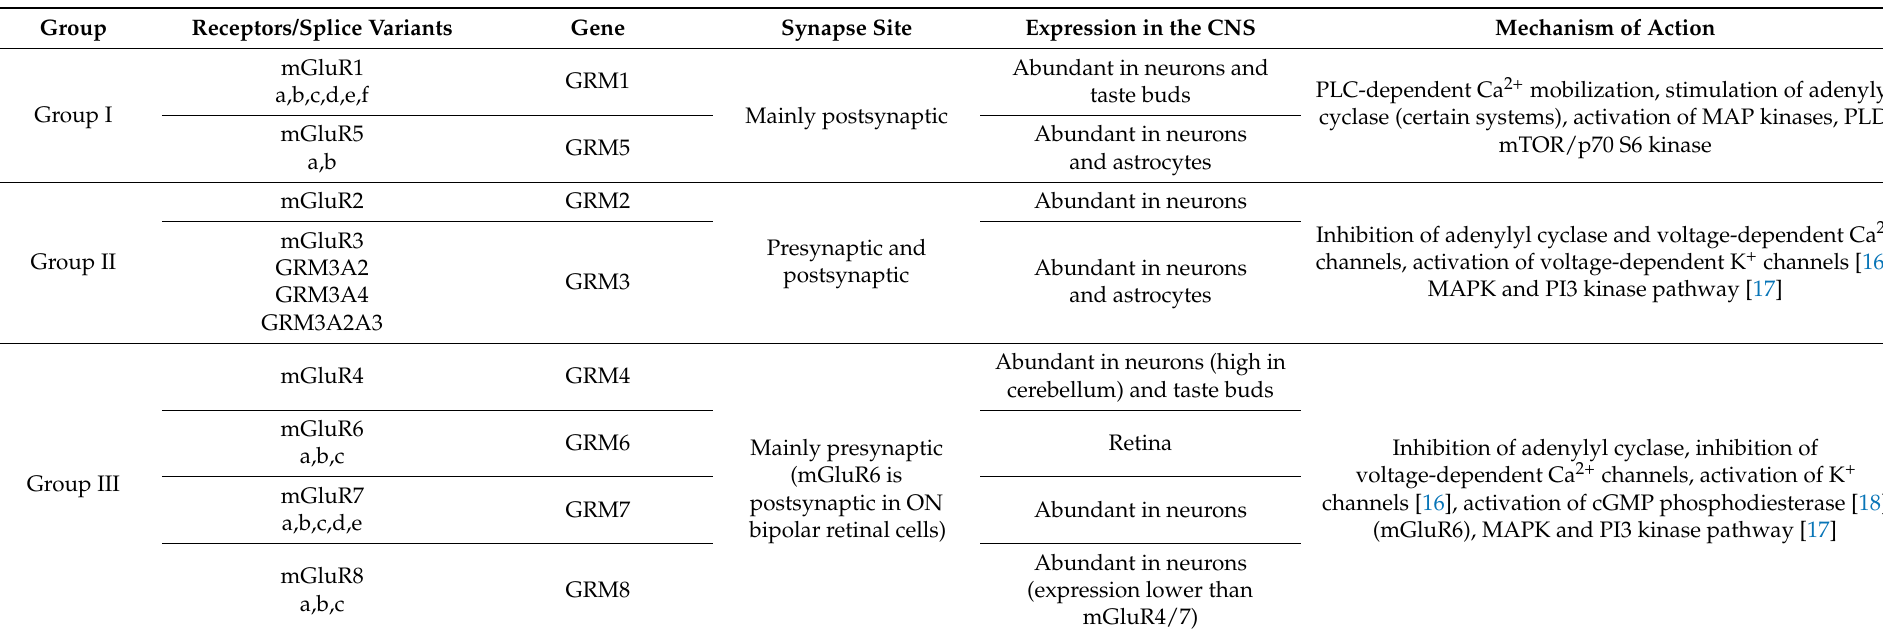
Table 1. General properties of mGluR family. Genes encoding eight mGluR subtypes have been identified, many with multiple splice variants described here as a-f. mGluRs are subclassified into three groups based on sequence homology, synaptic localization and mechanism of action. Group I includes mGluRs 1 and 5, Group II includes mGluRs 2 and 3, and Group III includes mGluRs 4, 6, 7, and